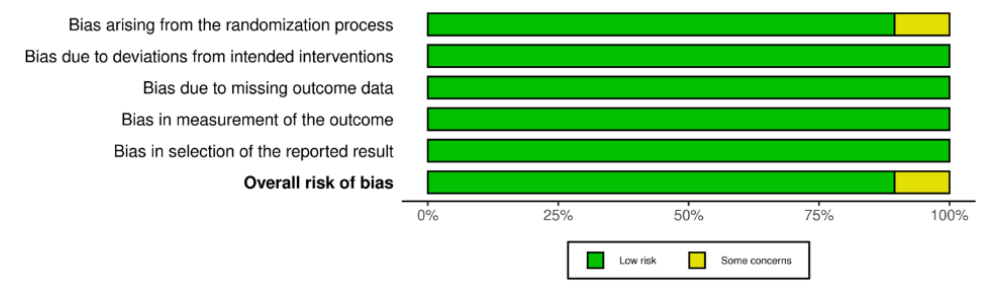
Figure 7. Summary plot for risk of bias assessment of the included studies using the revised Cochrane risk-of-bias tool for randomized trials (RoB-2) [8 – 26].